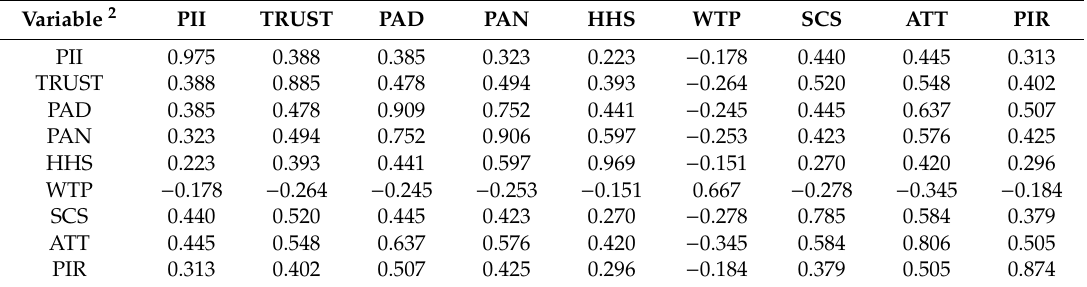
Table 4. Discriminant validity: correlations among latent variables with square roots of AVEs 1 . Variable